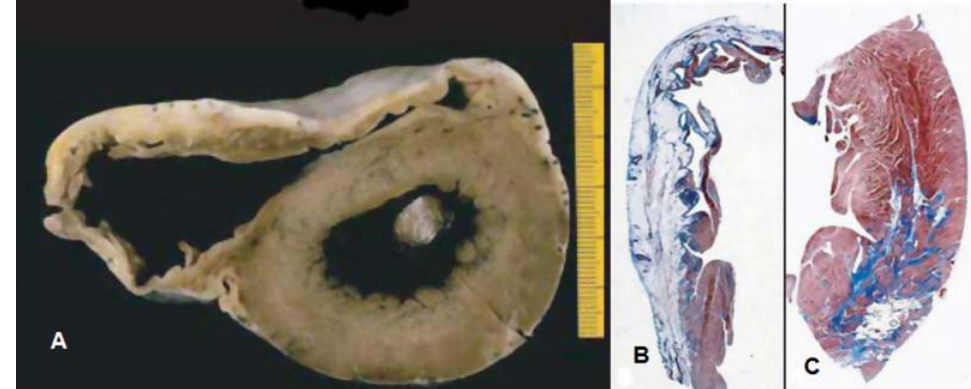
Figure 1. Arrhythmic cardiomyopathy pathology. A: Cross section of a heart of a 17 year old male who died suddenly during a football match. Note the right ventricular dilatation, fibro-fatty replacement and anterior and posterior wall aneurysms. B: Histology of the right ventricular free wall of the same patient showing transmural fibrofatty replacement. C: Histology of the left ventricular free wall showing focal subepicardial left ventricular involvement. (Modified from Thiene, G., Corrado, D. & Basso, C. Arrhythmogenic right ventricular cardiomyopathy/dysplasia. Orphanet journal of rare diseases 2, 45